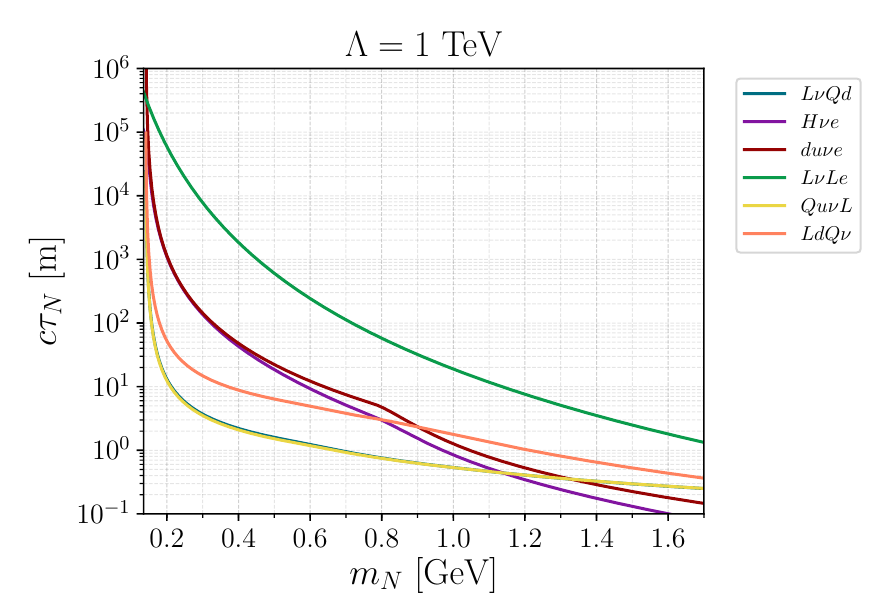
Figure 5 . Proper decay lengths of the sterile neutrino in various EFT scenarios for Λ = 1